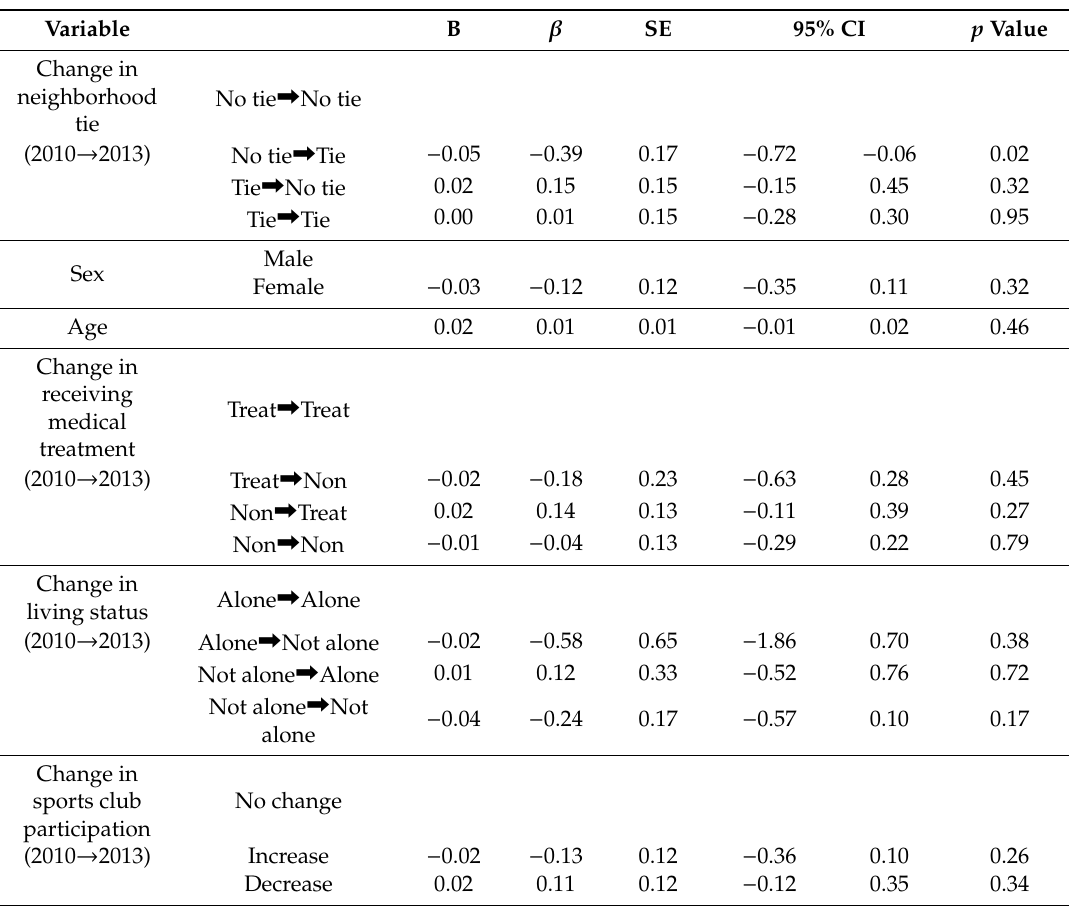
Table 2. Multivariate adjusted association of the change in the neighborhood ties with the change in the GDS score among the survivors from the 2011 disaster in